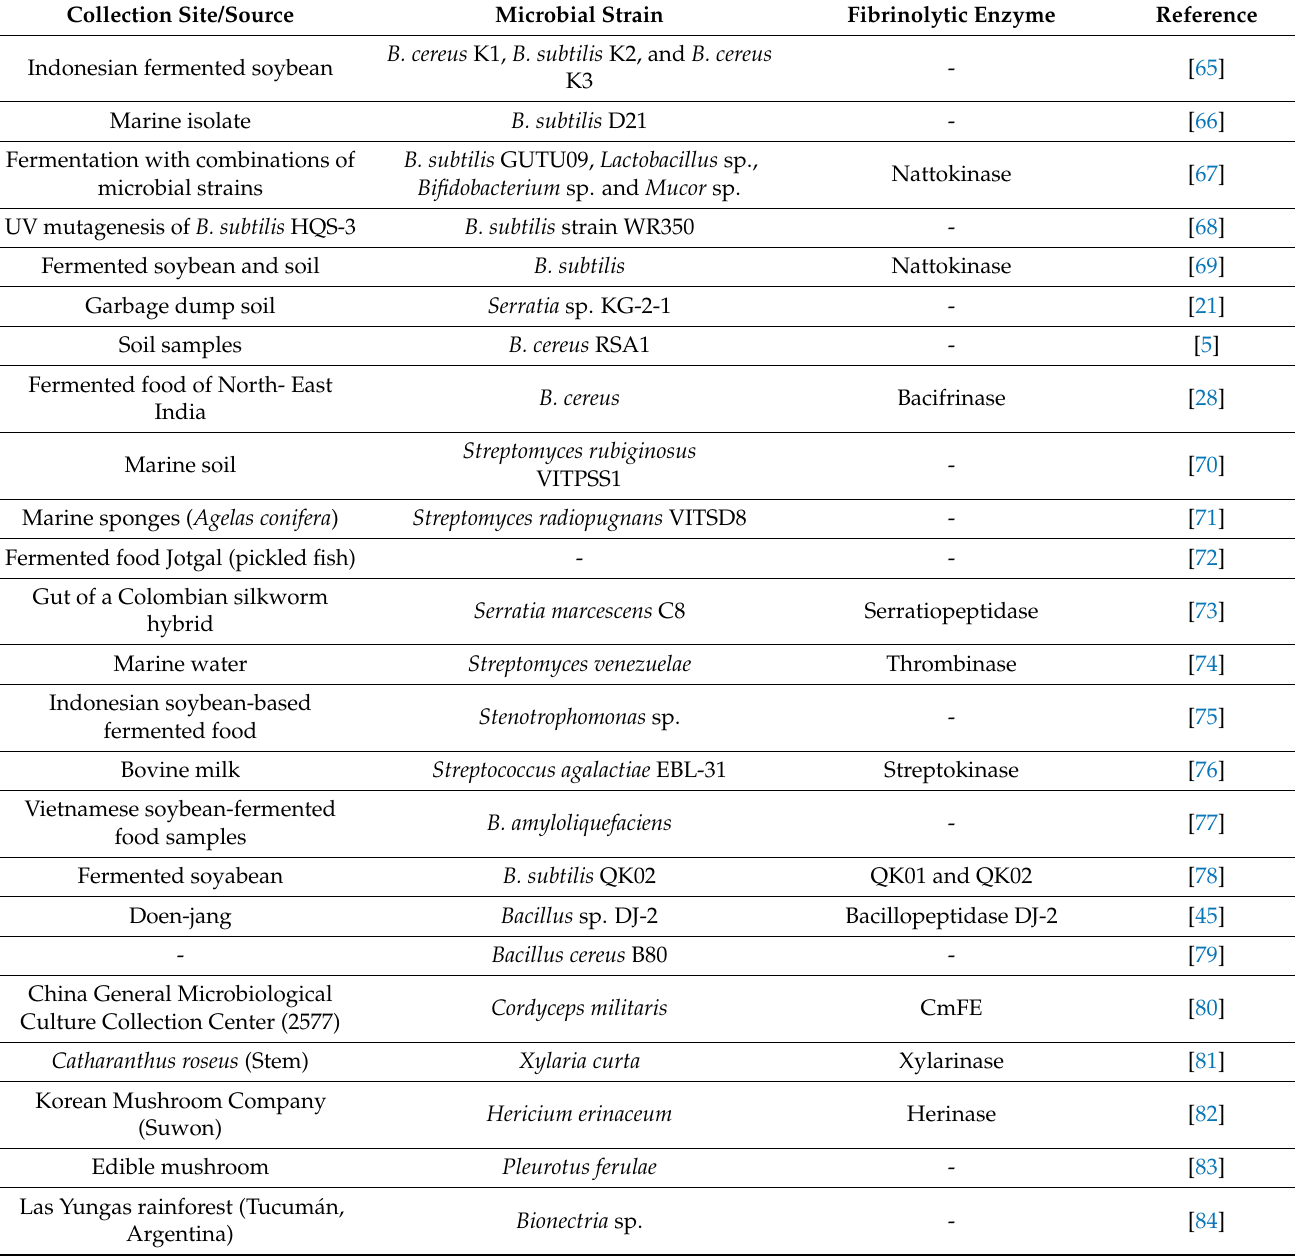
Table 1. Microbial sources of fibrinolytic